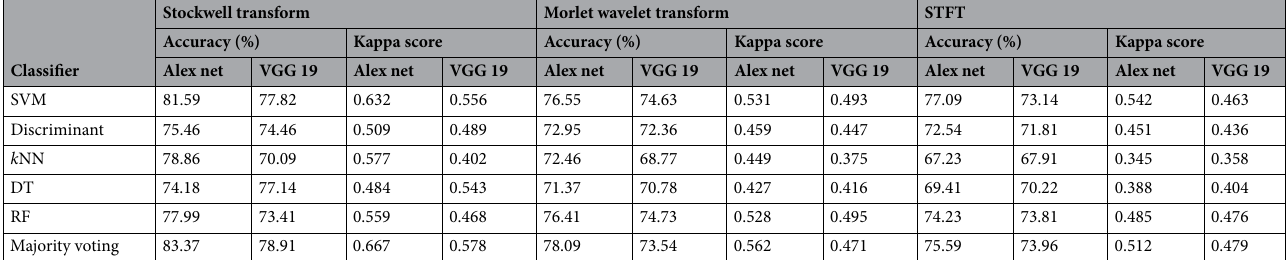
Table 5. Classification accuracy and Kappa scores for different machine learning approaches considering AlexNet and VGG19 networks for Stockwell transform, Morlet wavelet transform and STFT of dataset IV-2b.